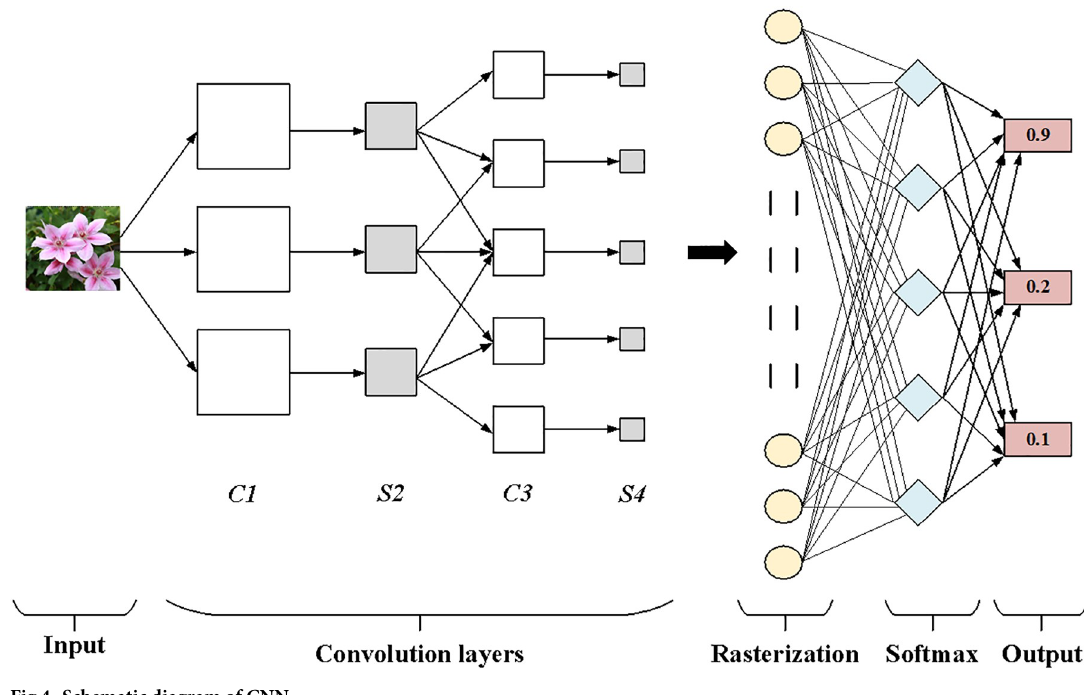
Fig 4. Schematic diagram of